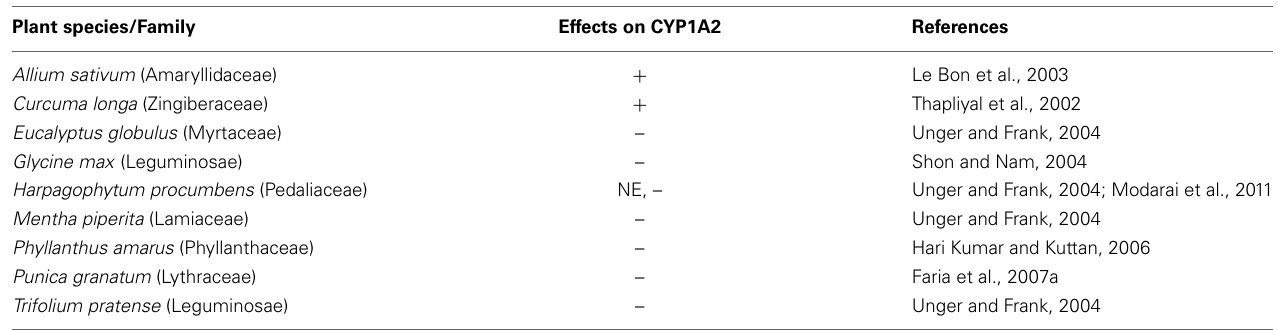
Table 1 | Medicinal plant species listed in RENISUS with reported effects of on CYP1A2.